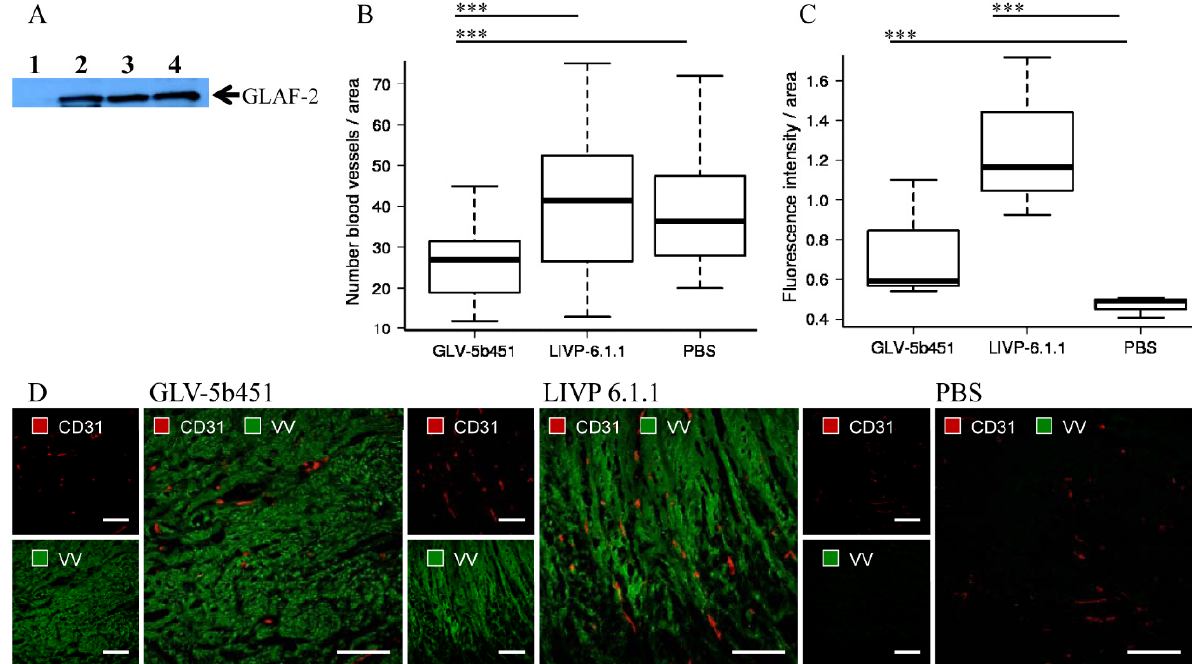
Figure 7. Presence of the scAb GLAF-2 ( A ) and analysis of vascular density in tumor tissues of virus- or PBS-injected STSA-1 xenograft mice at 17 dpvi ( B – D ). (A) Western blot analysis of GLV-5b451-infected STSA-1 tumors at 17 dpvi (lines 2–4). Line 1: Lysate of a LIVP 6.1.1-infected STSA-1 tumor (negative control). Each sample represents an equivalent of 1.5 mg tumor mass; (B,C) Visualization and analysis of vascular density using CD31 immunohistochemistry in LIVP 6.1.1, GLV-5b451 or PBS-treated tumors: (B) The vascular